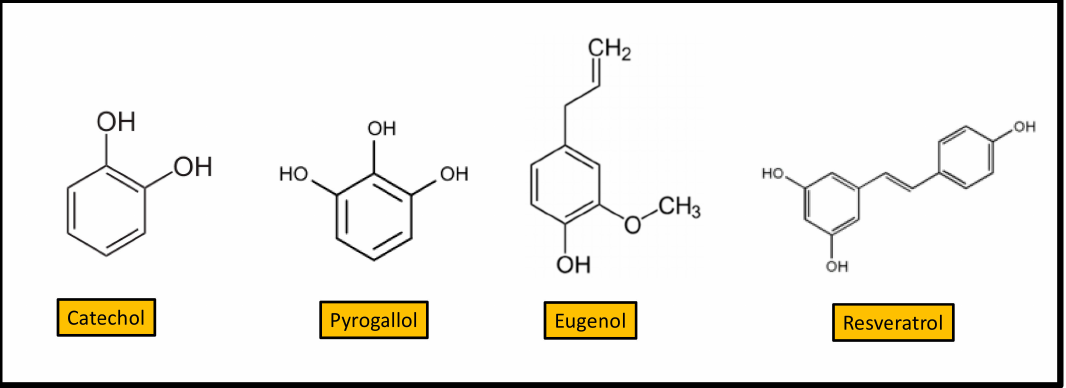
Figure 1. Structure of four simple phenols with antibacterial